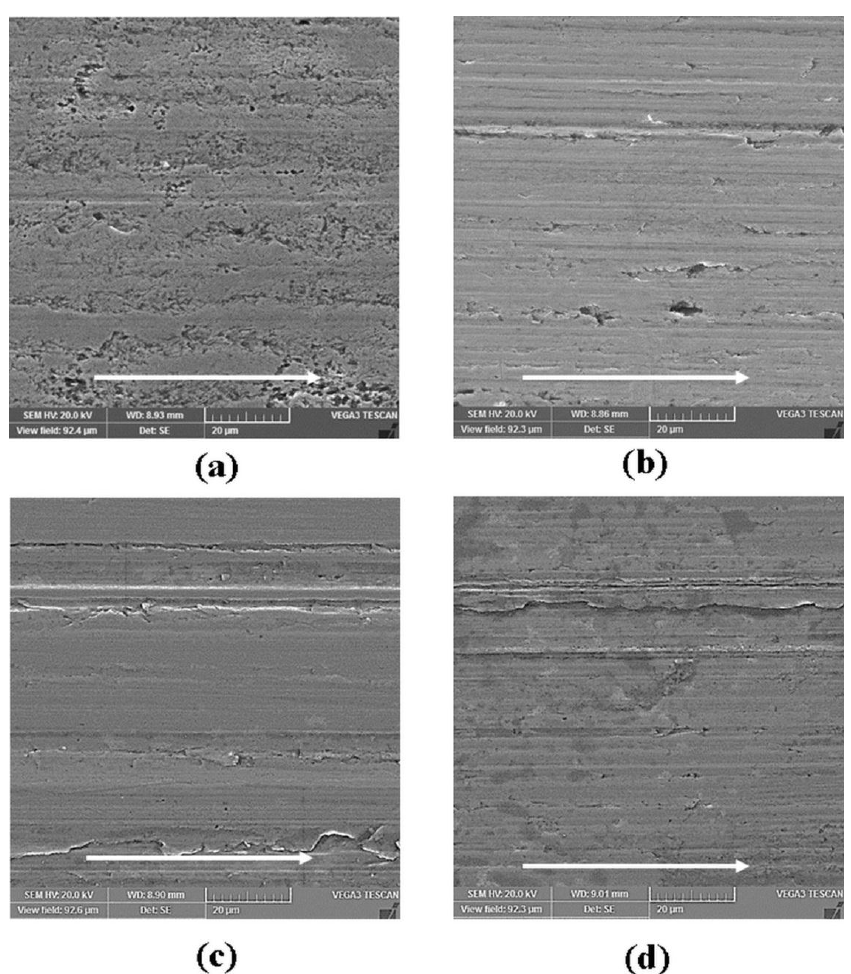
Figure 7. Scanning electron micrographs of blocks after tribological testing of: ( a ) MO, ( b ) MO + 0.01 wt. % HNTs, ( c ) MO + 0.05 wt. % HNTs, ( d ) MO + 0.10 wt. % HNTs. Arrows indicate the direction of sliding.